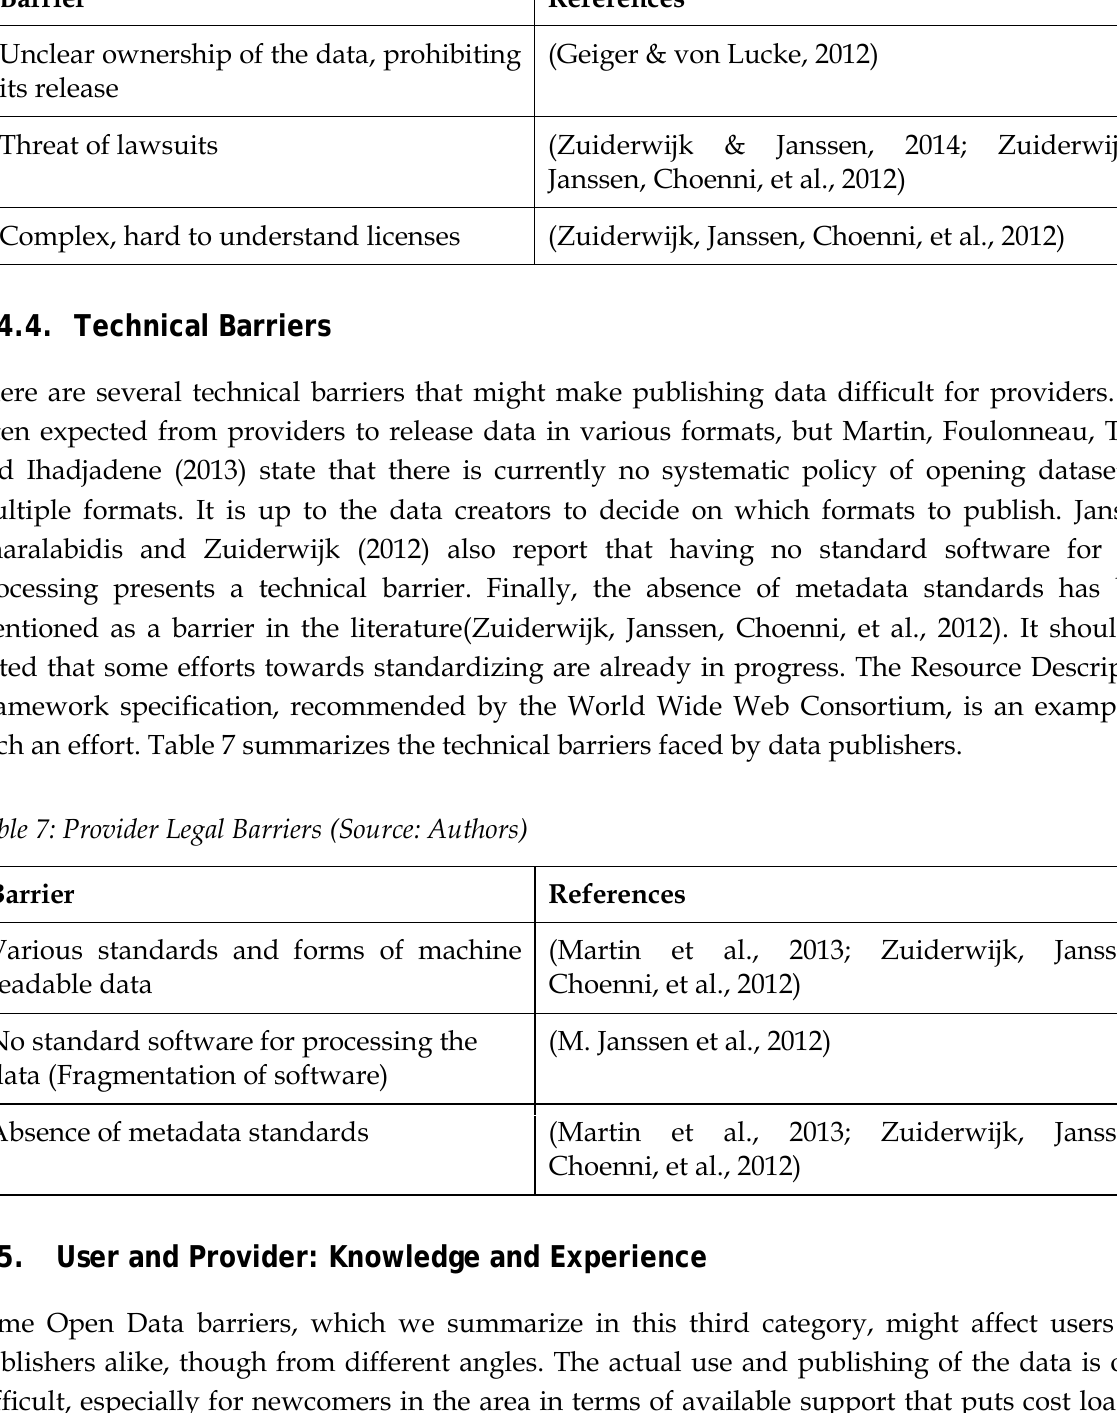
Table 6: Provider Legal Barriers (Source: Authors) Barrier